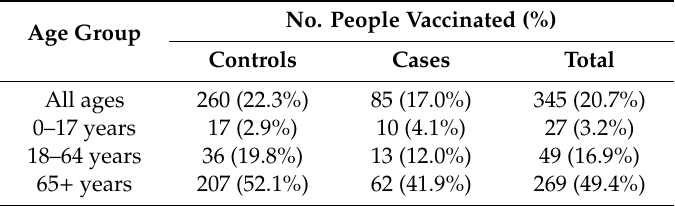
Table 2. Vaccine coverage overall and by age